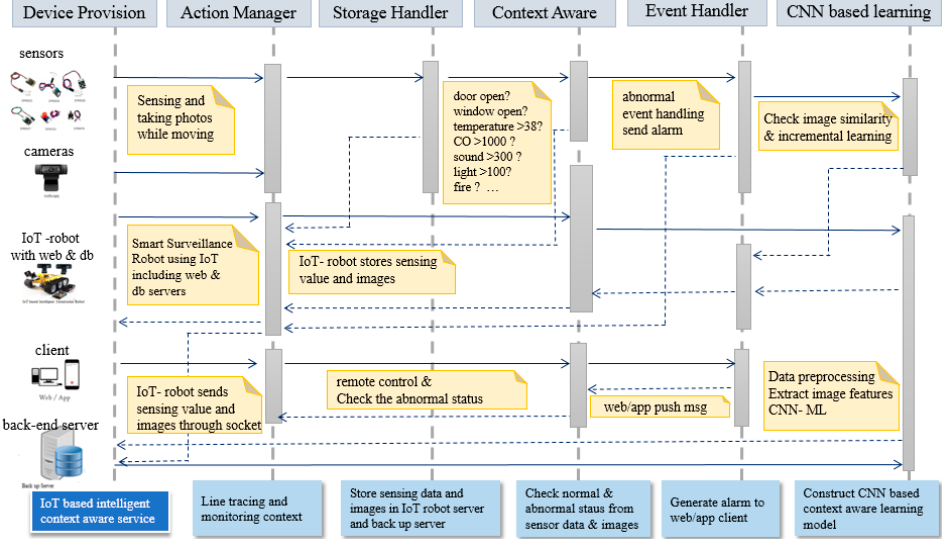
Figure 6. Sequence diagram of the IoT platform with an intelligent monitoring service.